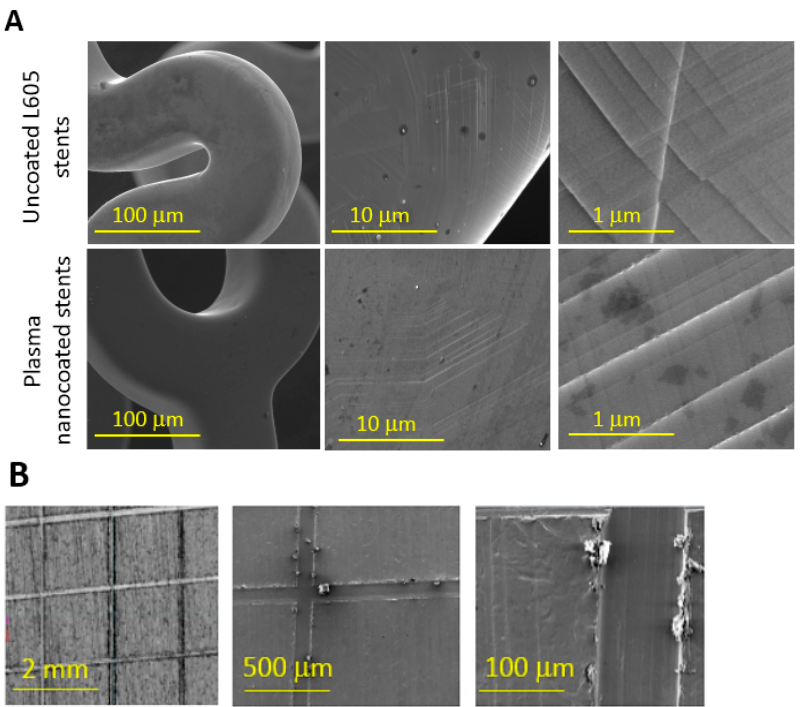
Figure 3. ( A ) SEM images of uncoated L605 stents and plasma-nanocoated L605 stents after crimp- ing and expansion, n = 3. ( B ) SEM images of plasma-nanocoated L605 coupons after adhesion test, n =